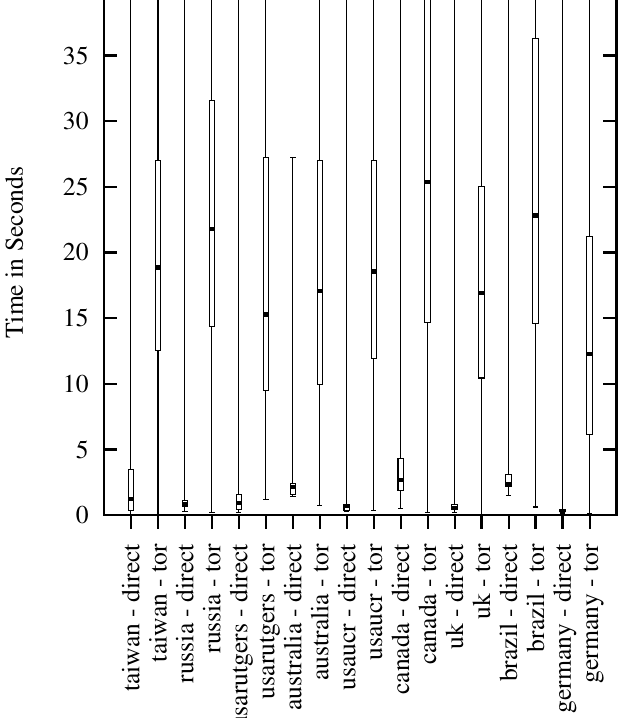
Figure 6. Average Download Throughput (Time for 1